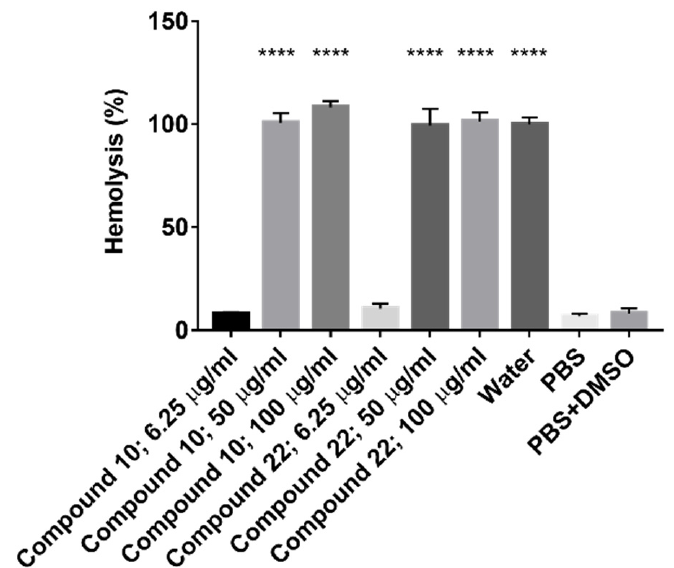
Figure 4. Hemolytic effect of compounds 10 and 22 on rat red blood cells. At 50 and 100 µg/mL, both compounds significantly increased the hemolysis of red blood cells after 15 min of incubation. (n = 3–6, **** p < 0.001).